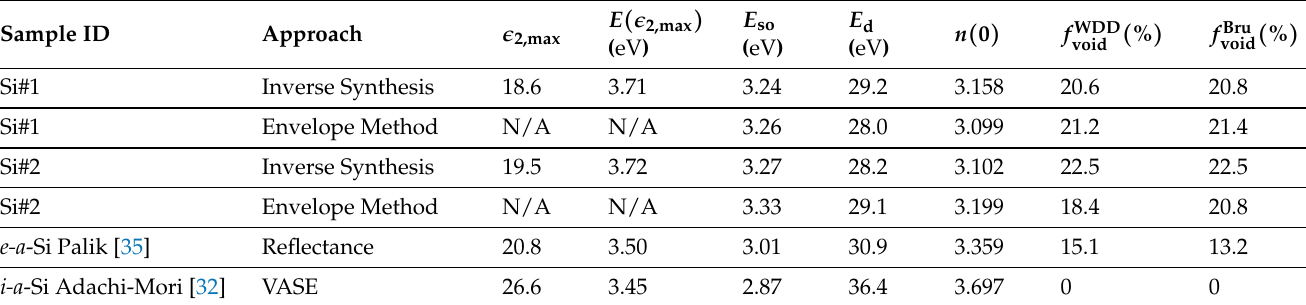
a -Si samples are also listed in Table 2. Table 2. Values of the height and position of the (cid:101) 2 peak, along with the refractive-index dispersion parameters revealed by the WDD single effective oscillator model, for various investigated a -Si materials. The different approaches used in order to determine the values of the presented optical parameters, are also listed in the